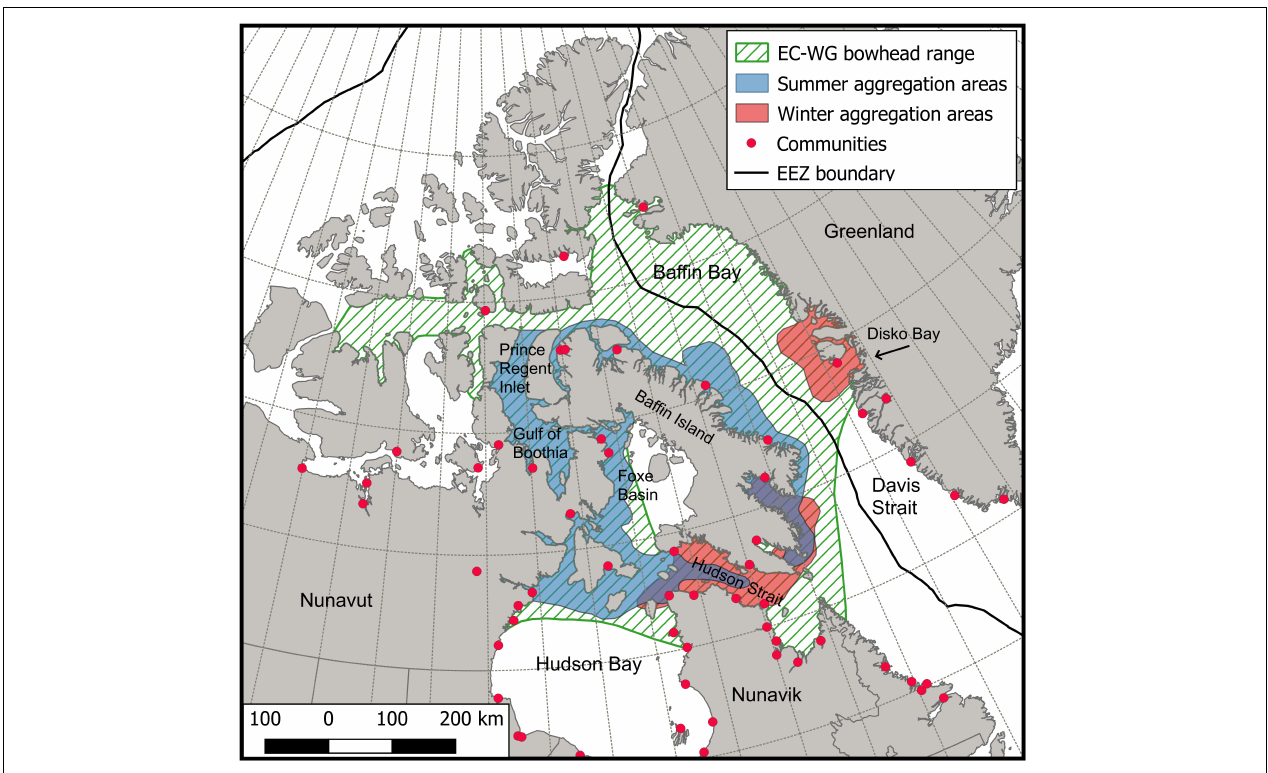
FIGURE 1 | Approximate geographic range of the Eastern Canada-West Greenland bowhead whale population, with important aggregation areas during the open-water (“summer”) and ice-covered (“winter”) seasons. Community locations are shown, and Table 2 indicates those communities (and their locations) where bowhead whale subsistence hunts have occurred. Geographic range and summer and winter aggregation areas modified from NWMB (2000), COSEWIC (2009), Heide-Jørgensen et al. (2021), DFO, unpubl. data, and GINR, unubl.